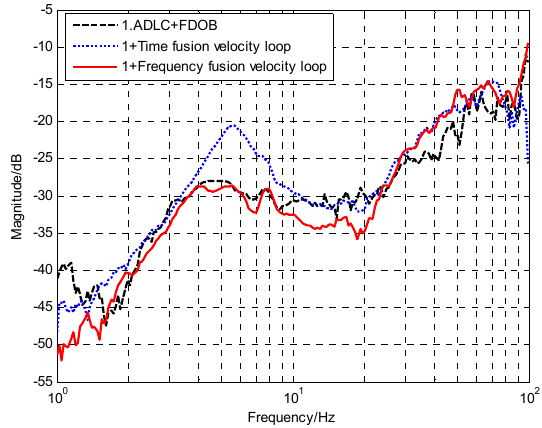
Figure 13. The comparison of DS with time-domain and frequency-main fusion methods.